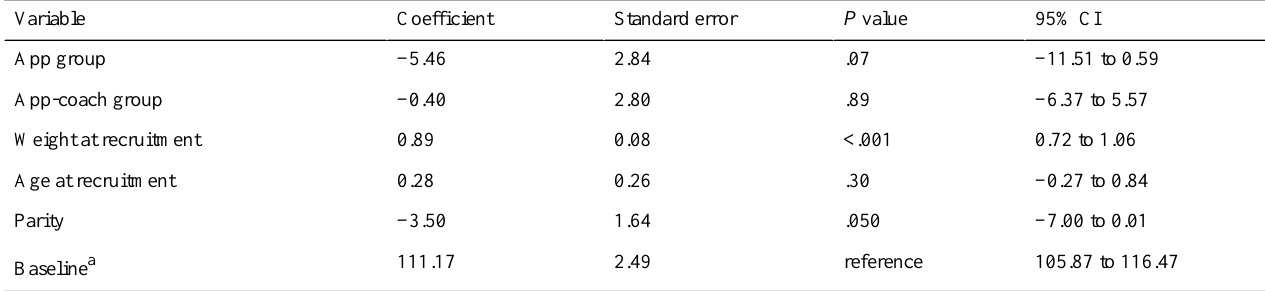
Table 4. Results of the statistical model investigating gestational weight